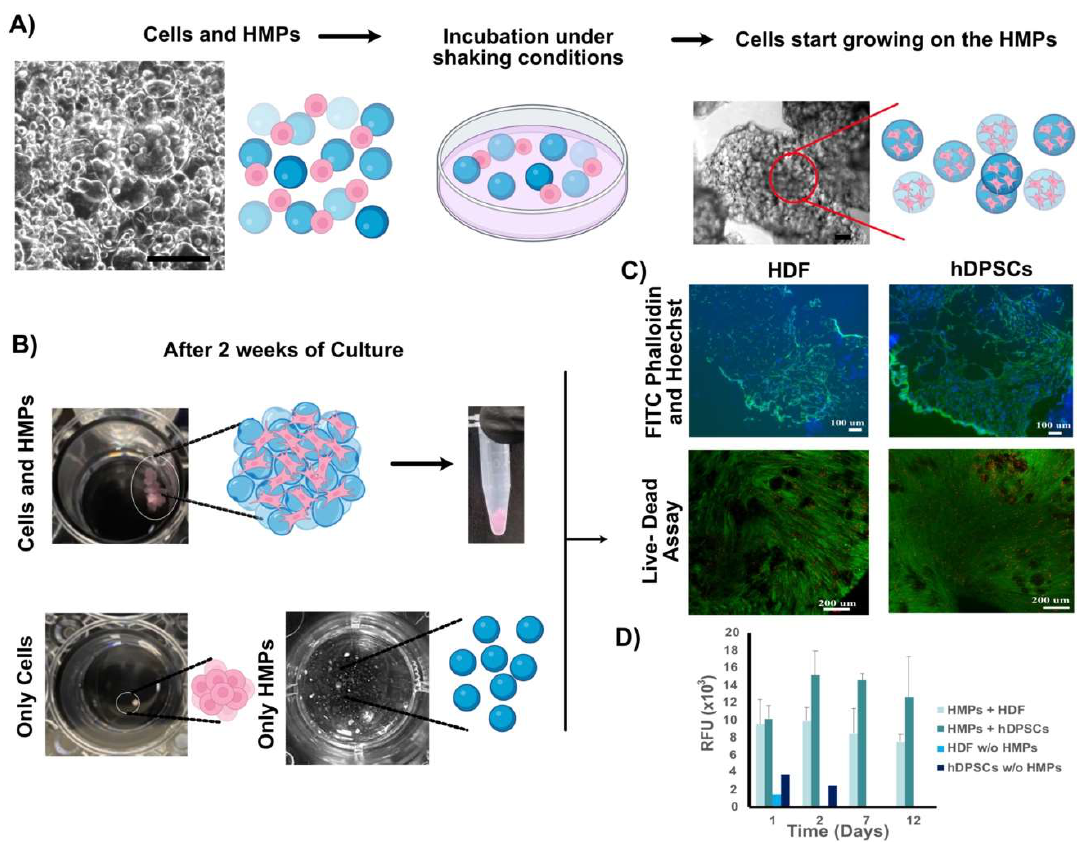
Figure 3. In vitro biocompatibility tests of self-assembled cell-HMP aggregates: ( A ) hDF cells or hDPSCs seeded together with GelMA hydrogel microparticles (GelMA HMPs) and incubated in ultralow attachment plates with rocking formed tissue-like constructs by Day 1. Scale bars in A: 200 µm. ( B ) After 2 weeks of culture cell-HMPs formed tissue-like aggregates that were easy to handle. Cells without HMPs formed ten times smaller clusters, and HMPs alone did not adhere together, but rather remained distributed throughout the media. ( C ) Cryosections (5 µm in thickness) of tis- sue-like clusters stained with FITC-Phalloidin (upper panel) and with Live-Dead dyes (lower panel). Scale bars: 100 µm (top) and 200 µm (bottom). ( D ) Cell viability in the presence or absence of HMPs was measured using an Alamar Blue viability assay over 12 days (data shown are mean ± SD, n = 3) Abbreviations: HDF, human dermal fibroblasts; hDPSCs, human dental pulp stem cells; HMPs, hy- drogel microparticles.